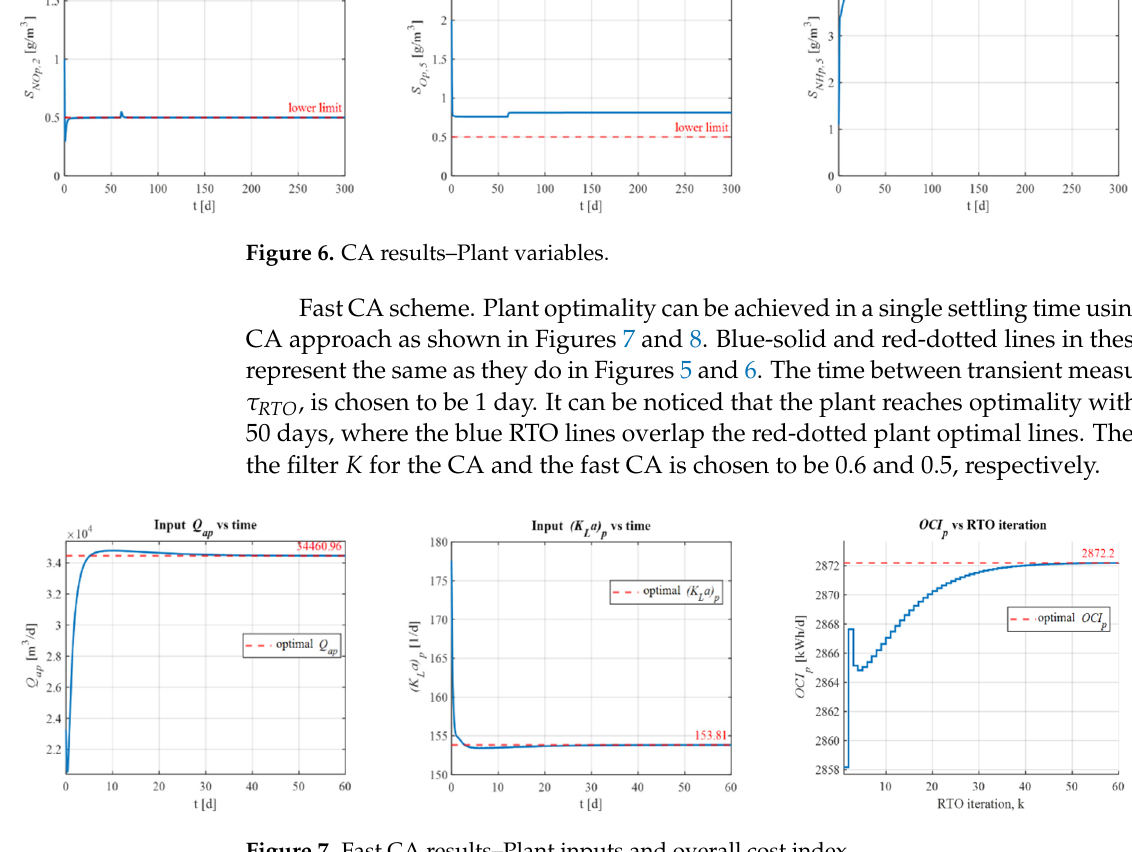
Figure 8. Fast CA results—Plant variables.